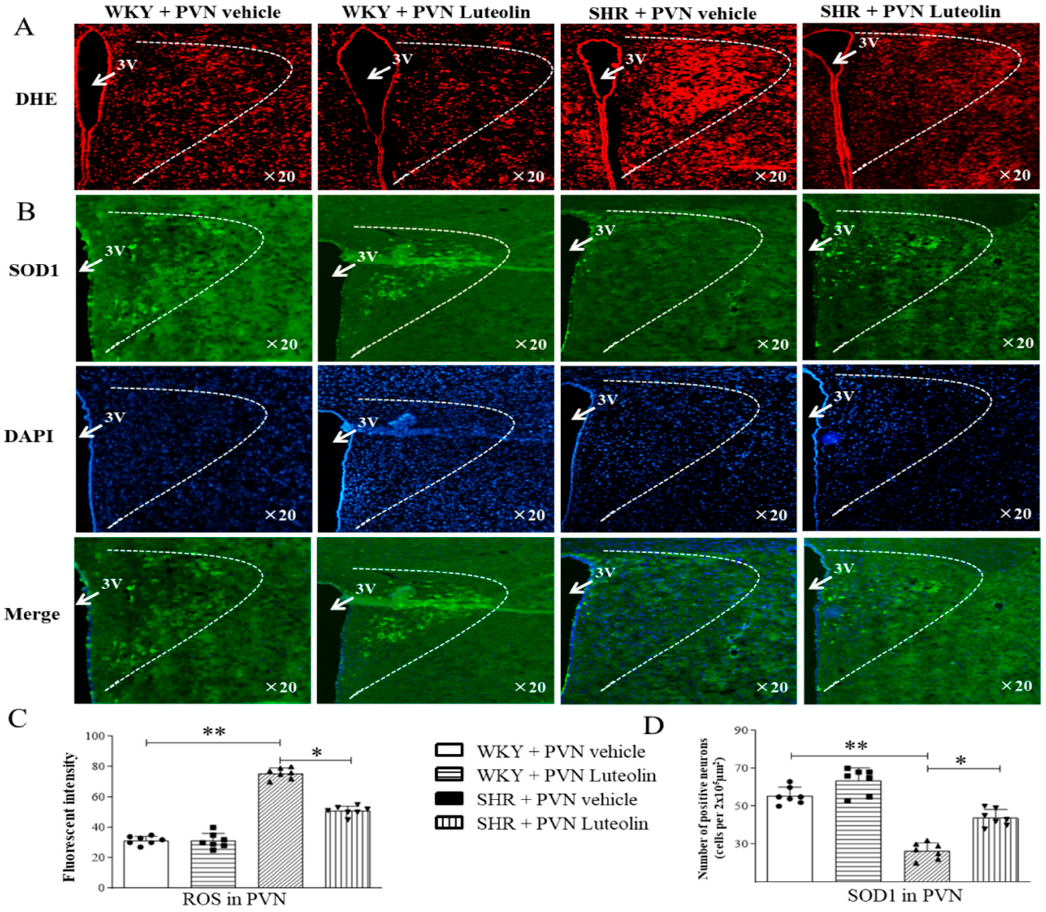
Figure 2. Effects of PVN luteolin on ROS and SOD1 in PVN. ( A ) A representative fluorescent microphotographs depicting the superoxide production as detected with dihydroethidium staining (DHE, red fluorescence). ( B ) A representative fluorescent microphotographs revealing SOD1 positive cells (green fluorescence). Quantification analysis of red fluorescence of DHE ( C ) and green fluorescence of SOD1 ( D ) positive cells in PVN of SHRs and WKY rats, treated with luteolin or aCSF. Values are the mean ± SEM from 7 rats/group. * p < 0.05, ** p < 0.01. 3V, third ventricle. Immunofluorescence staining showed a lower SOD1 positive cell count (Figure 2B,D) in the PVN of SHRs. However, luteolin infusion in SHRs led to an increase in the number of SOD1-positive